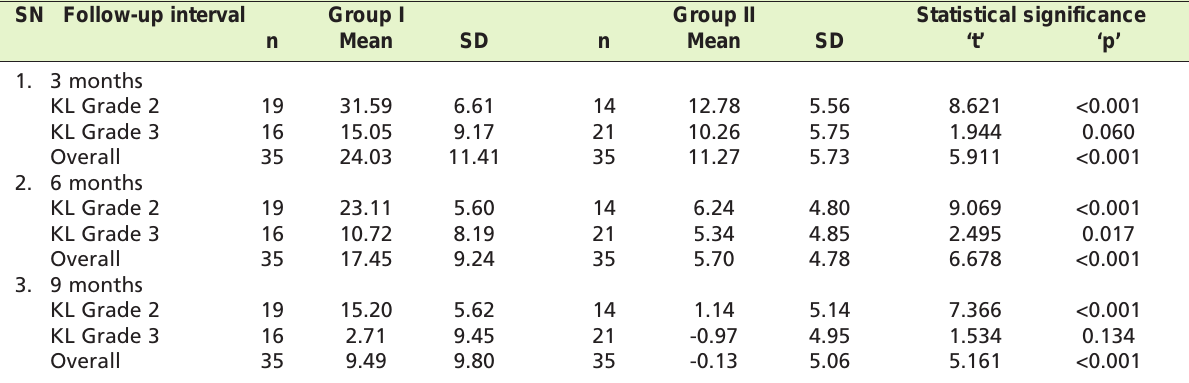
Comparison of overall percent reduction in VAS Score between two groups at nine months (final follow-up) Table VIII: SN Variable Group I Group